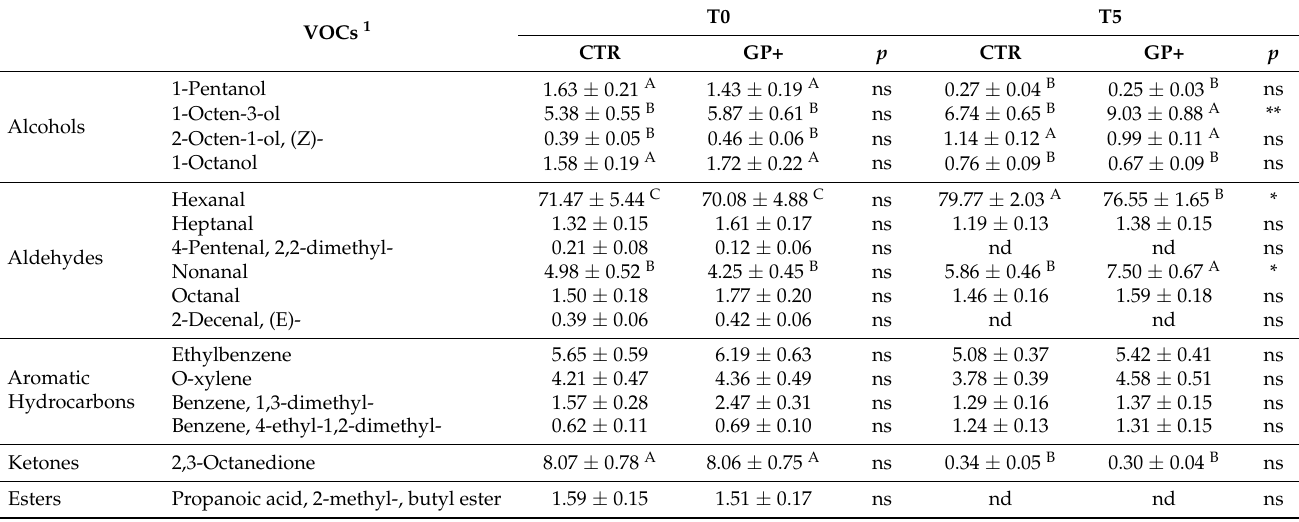
Table 5. Volatile compounds (VOCs) identified in longissimus dorsi samples obtained from lambs fed with a standard diet (CTR) and lambs fed a dietary supplementation with grape pomace (GP+). Samples were analyzed after cooking (T0) and after 5 days of storage (T5) at 4 ◦ C. VOCs 1